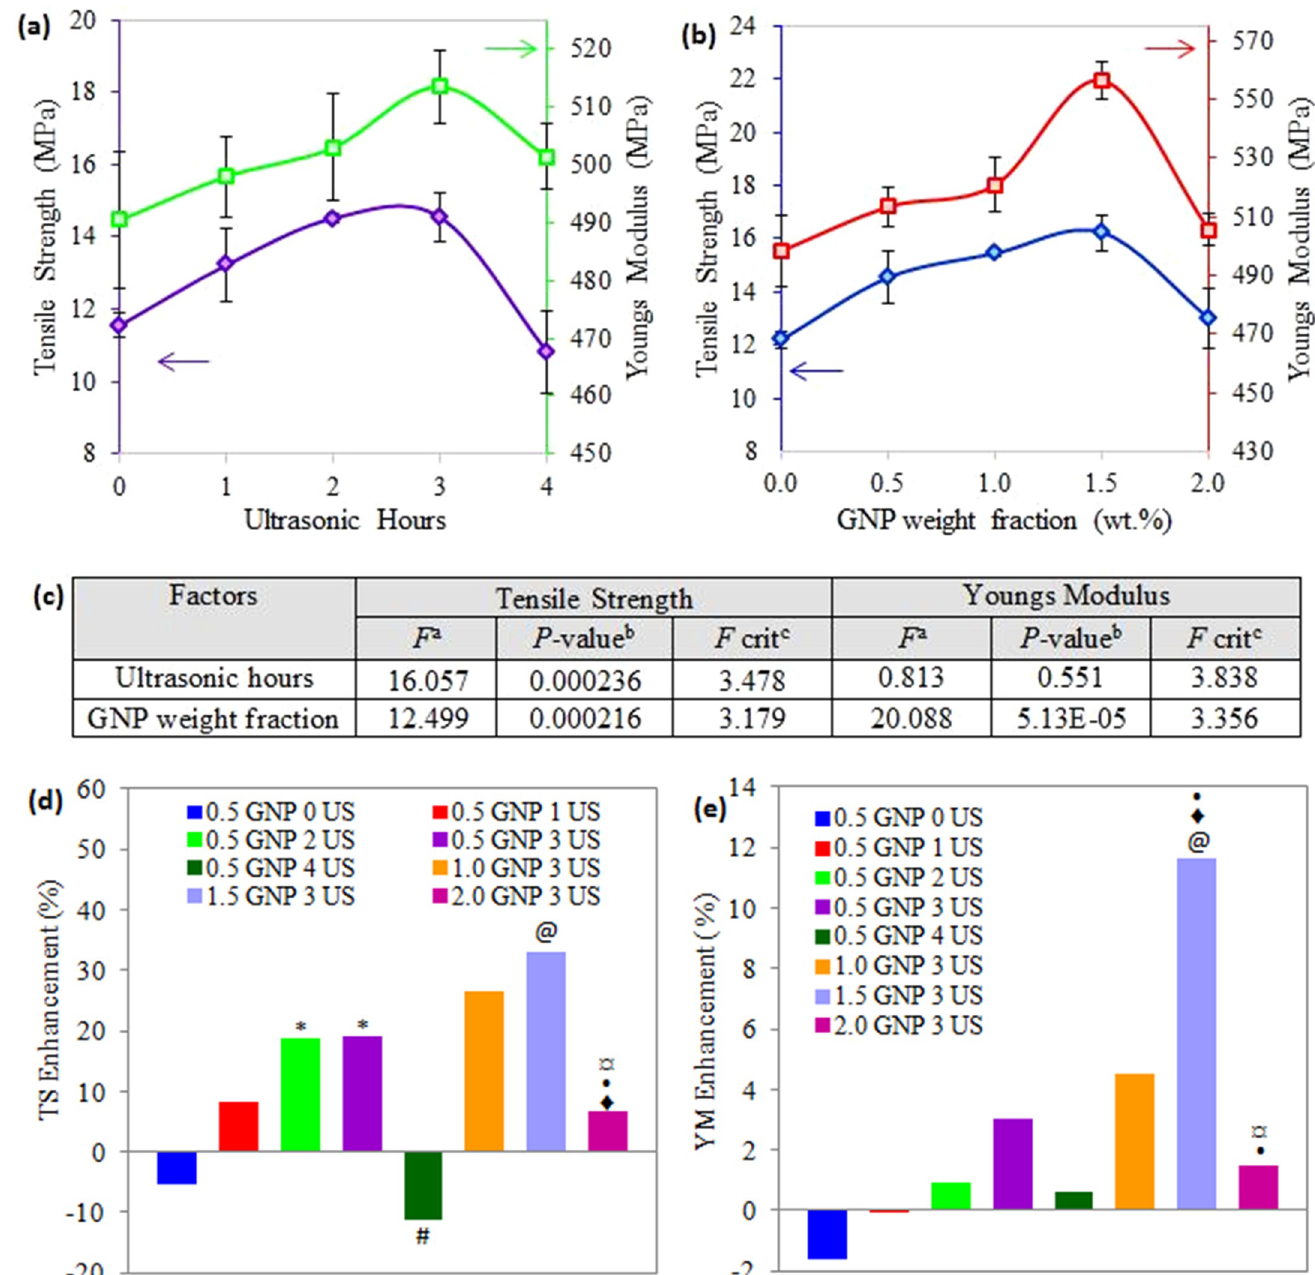
Fig 1. Tensile strength (TS) and Youngs Modulus of TPNR/GNP composites (a) treated with different ultrasonic (US) hours, (b) at various filler weight fractions, (c) ANOVA analysis for both factors in tensile properties, (d) TS enhancement and (e) YM enhancement of investigated composites compared with pure TPNR. Note: a F value = mean between groups variance/ mean within group variance; b Probability from 0 to 1; c critical F value based on F distribution. Groups with a significant difference (p < 0.05) compared to (i) TPNR/GNP composite without US assistance (0 hour) and assisted with 3 hours US are indicated by � and # respectively; (ii) TPNR composites without GNP, incorporated with 0.5 wt.% GNP, 1.0 wt.% GNP and 1.5 wt.% GNP are indicated by @, ♦ , • and ¤ symbols,